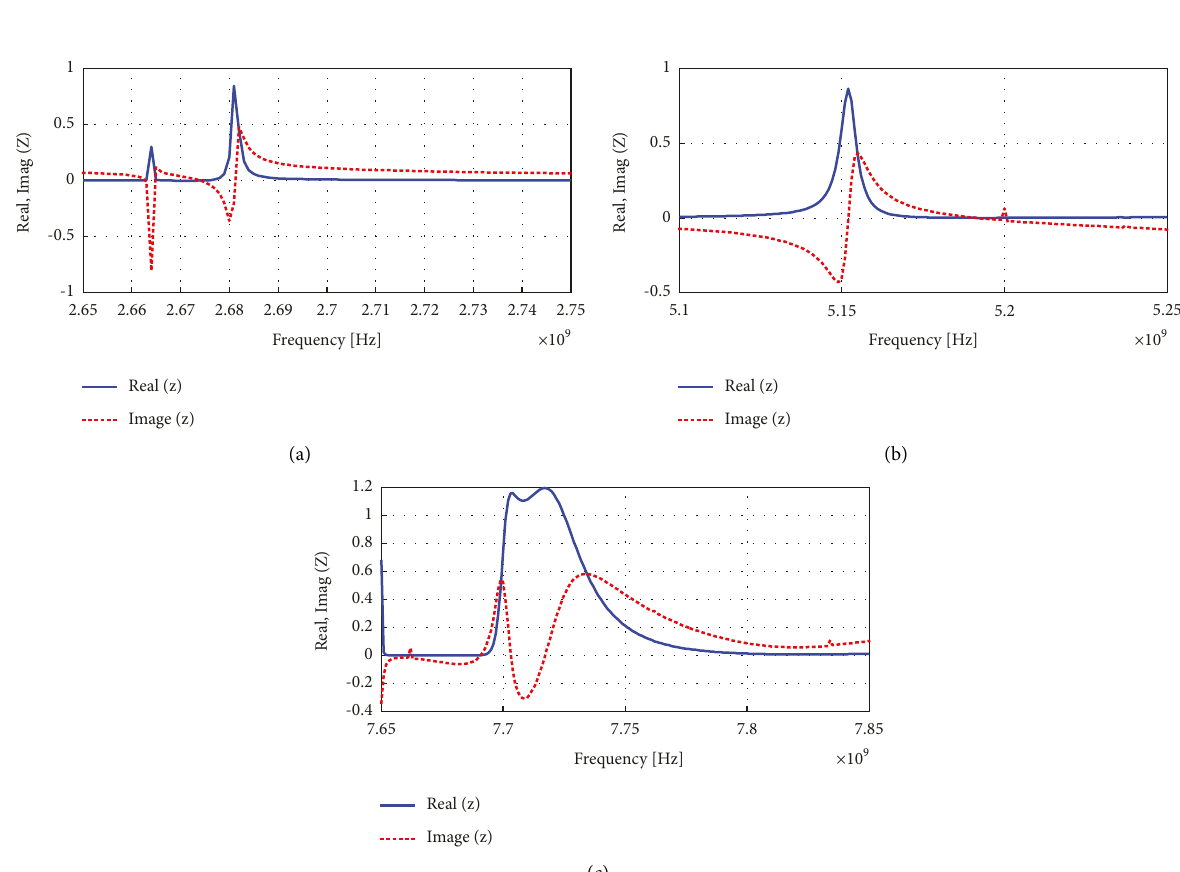
Figure 3: The proposed fractal